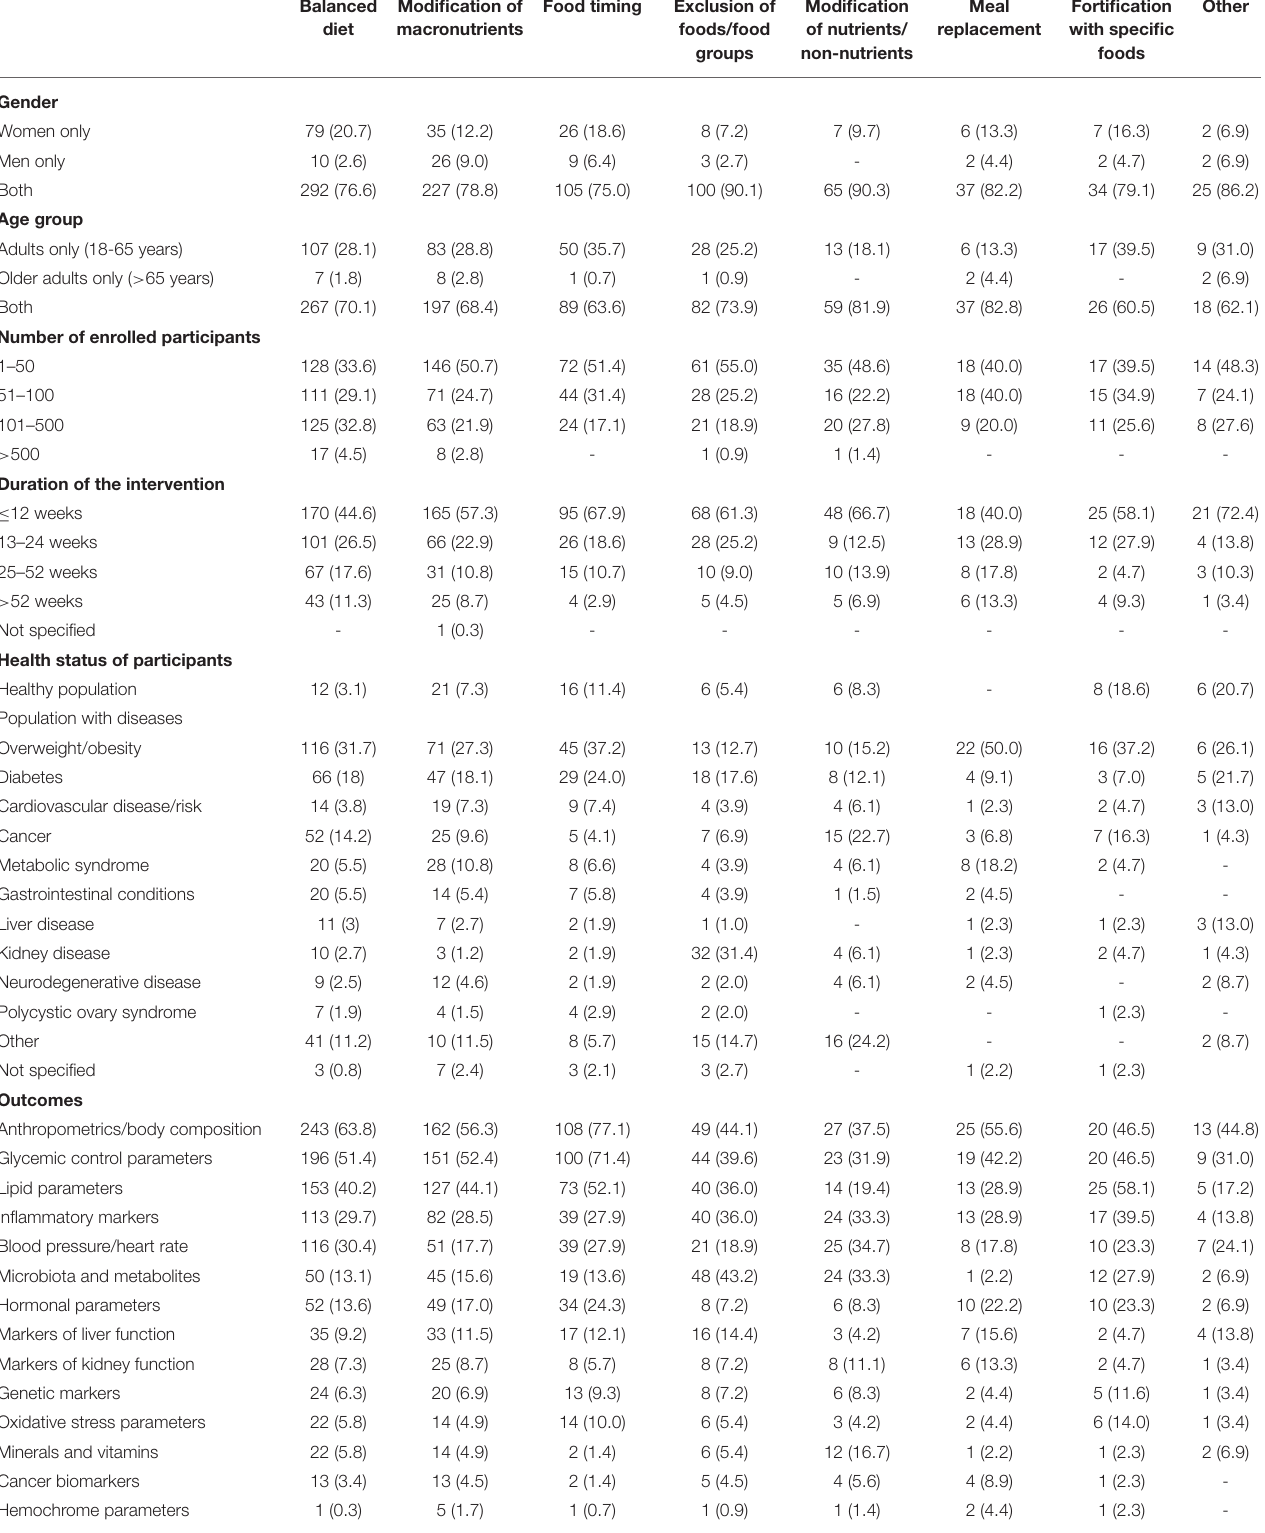
TABLE 2 | Characteristics of included trials registered on ClinicalTrials.gov from 2010 to 2020 according to dietary approaches.